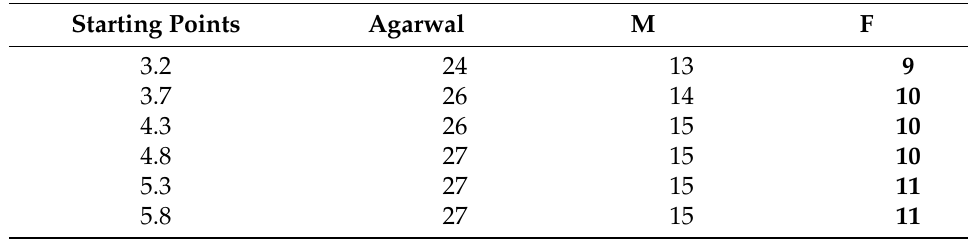
Number of Iterates for Obtaining Fixed Point.